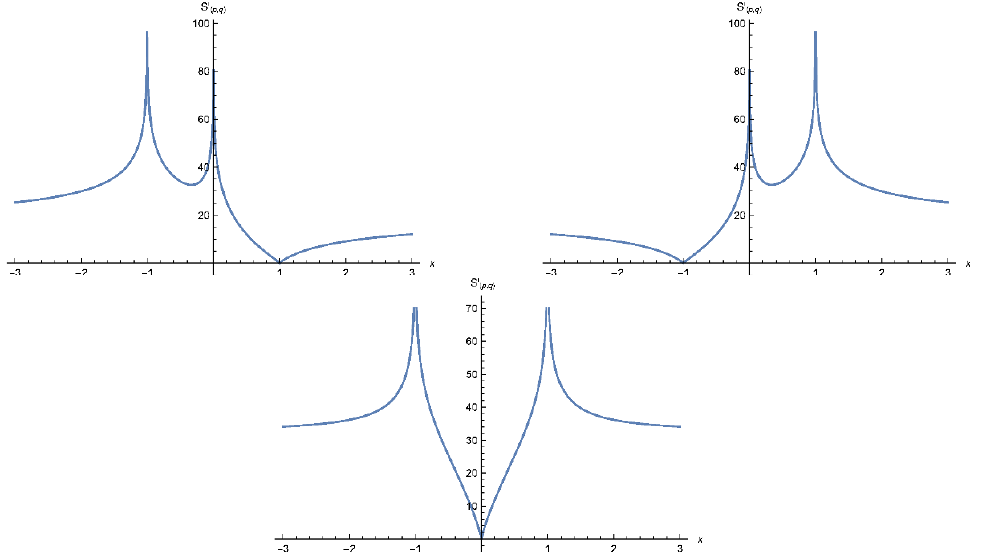
Figure 13 . Energy pro(cid:12)les of probe string embeddings in three-pole backgrounds (3.14). The probe string is taken to have the following charges: top row, left to right: (cid:6) ( (cid:0) q 1 ; p 1 ) and (cid:6) ( (cid:0) q 2 ; p 2 ), bottom row: (cid:6) ( q 1 + q 2 ; (cid:0) ( p 1 + p 2 ) ). These have vanishing energy when they lie on A-, C-, and B- branes, respectively. For explicit results, we have taken ( p 1 ; p 2 ; q 1 ; q 2 ) = (1 ; 1 ; (cid:0) 1 ;